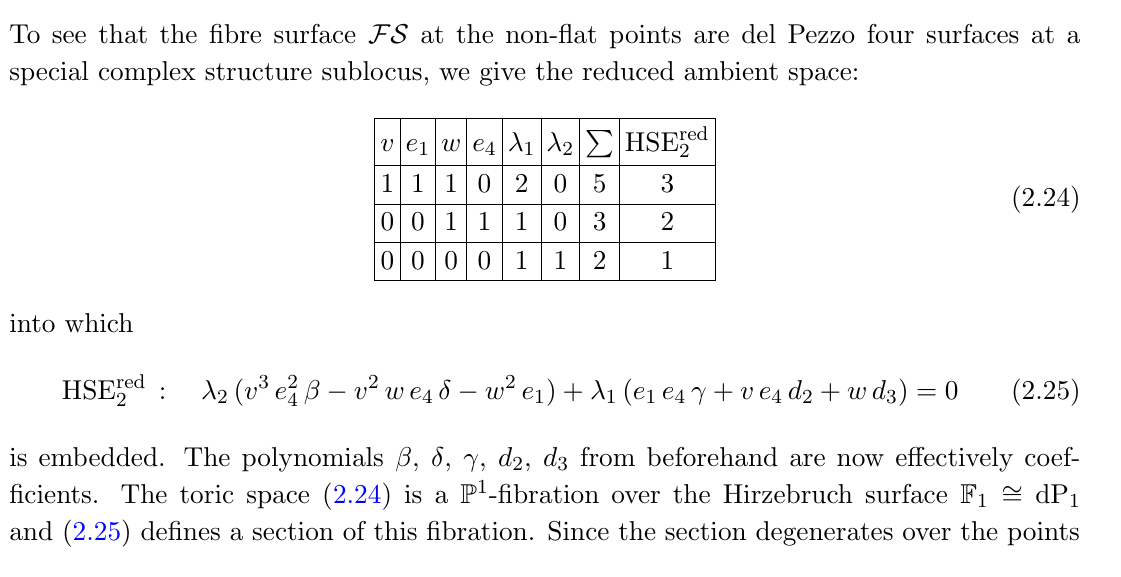
Figure 1 . A sketch of the matter curves and Yukawa points within the SU(5) GUT divisor f ! = 0 g . The seven bold dots indicate the six Yukawa points of (2.18) plus the triple intersection of the 5 1 -curve with the 10 3 (cid:0)